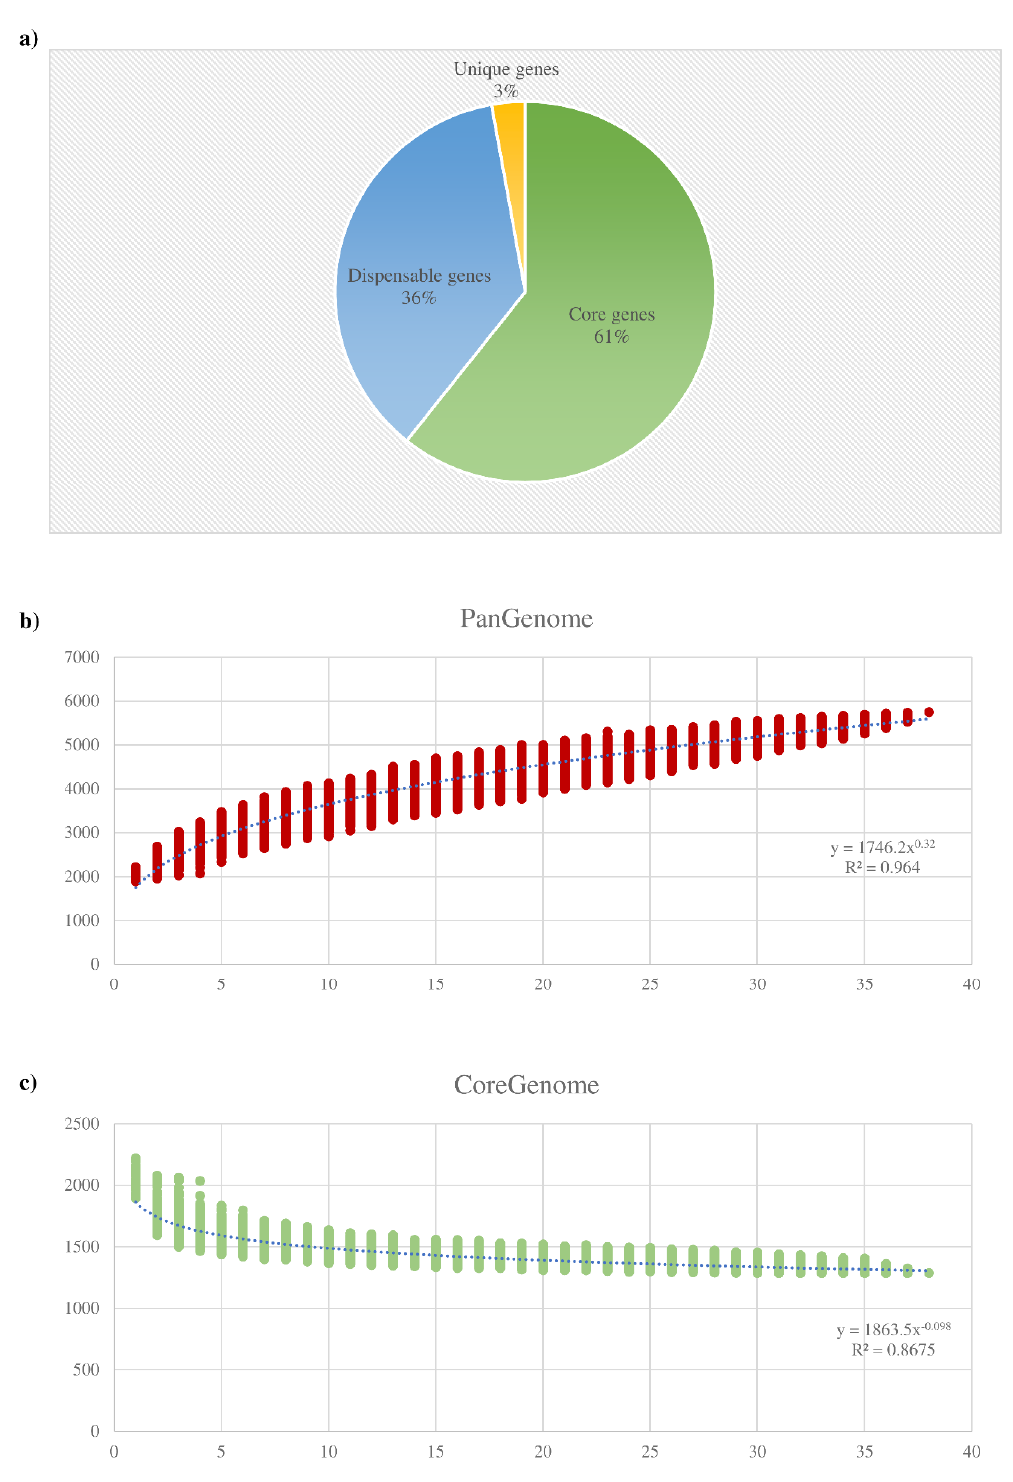
Figure 1. B. dentium pangenome and core genome: ( a ) displays the number of core genes (green), unique genes (yellow), and dispensable genes (blue) identified in the pangenome analysis; ( b ) shows the pangenome size based on the sequential addition of the 38 B. dentium genomes; ( c ) illustrates the core genome size based on the sequential addition of the same genomes.